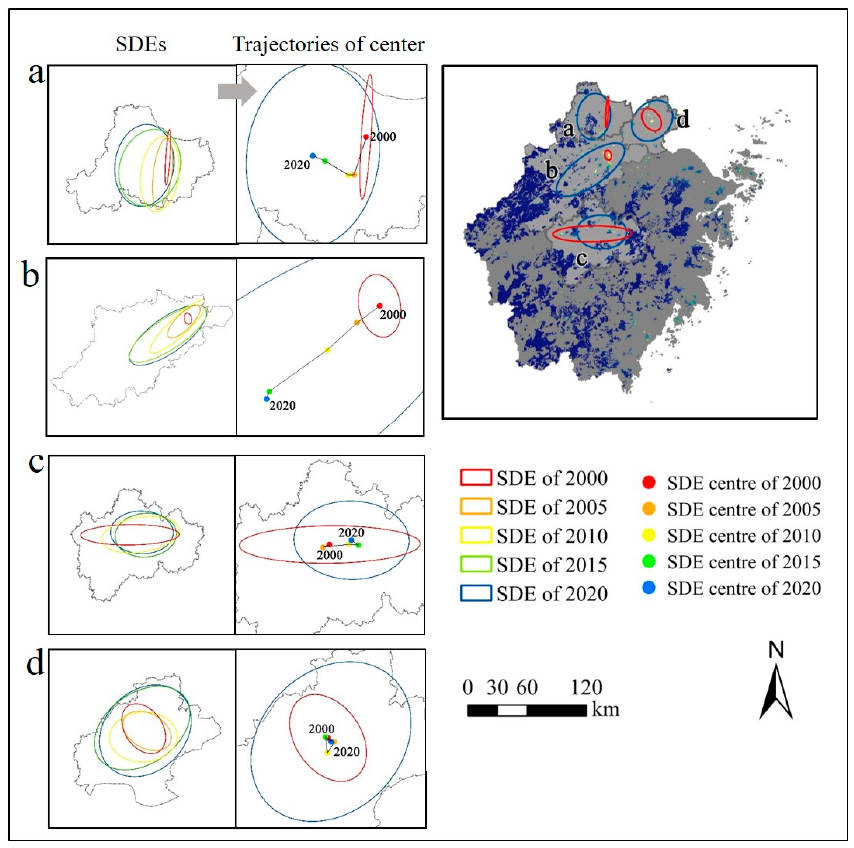
Figure 6. SDEs of ALAN in four cities: ( a ) Huzhou; ( b ) Hangzhou; ( c ) Jinhua; ( d ) Jiaxing. The centers of the SDEs of most cities showed significant regional migration trends except for those in Jiaxing. The SDEs in Hangzhou were in a “northeast-southwest” pattern after 2005, with ratios between major axes and minor axes larger than 2.5, showing that ALAN had clear directionality. In Huzhou, the rotation increase rotated the SDEs clockwise from 2000 to 2015. The direction was elongated to the southeast and northwest,